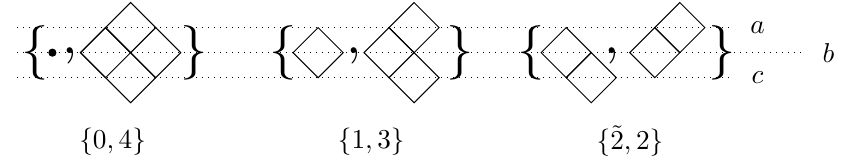
Figure 3 . The list of allowed diagram pairs for the case when n = 1 is { 0 , 4 } , { 1 , 3 } , { ˜2 , 2 } , { 4 , 0 } , { 3 , 1 } , { 2 , ˜2 }